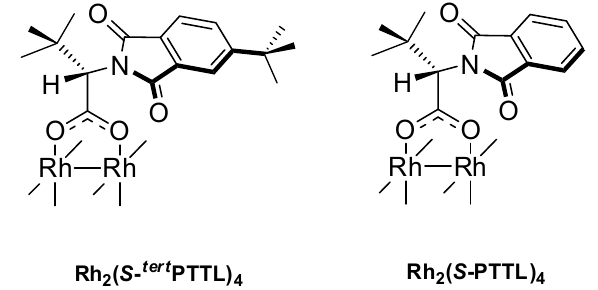
Figure 1. Structure of Rh 2 ( S ‐ tert PTTL) 4 and Rh 2 ( S ‐ PTTL) 4 .